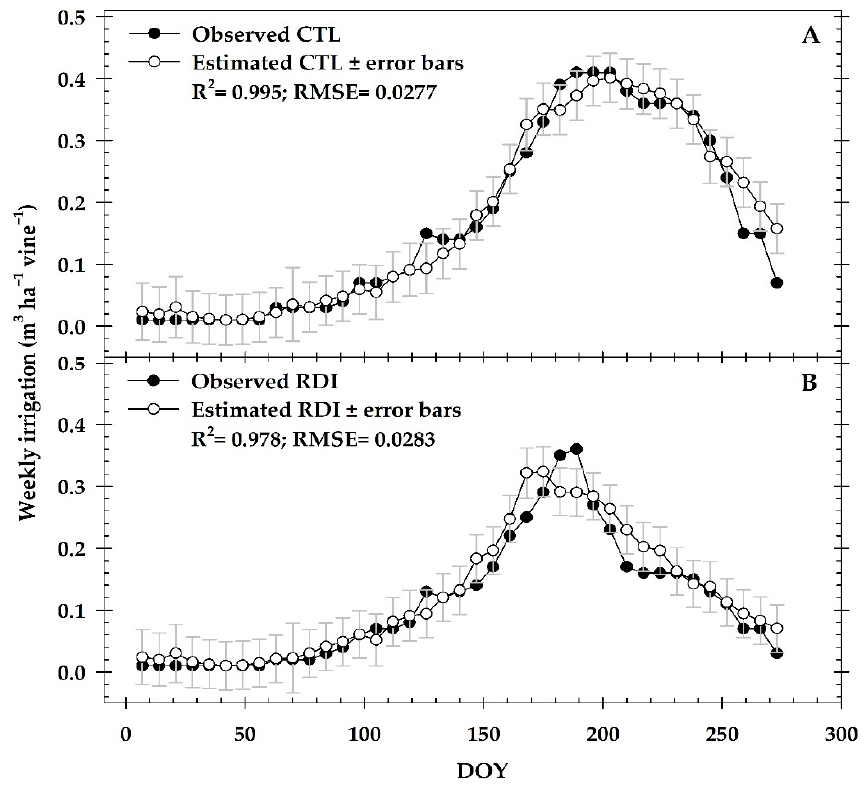
Figure 7. Estimated (white circles) and observed (black circles) weekly irrigation (m 3 ·ha − 1 ·vine − 1 ) for CTL ( A ) and RDI ( B ) treatments referenced to the day of the year (DOY) for 2017.